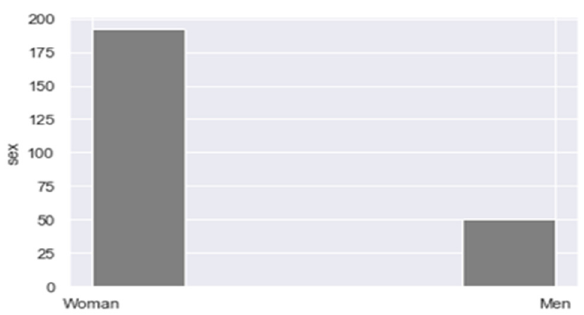
Figure A1. Profile of respondents by gender. Source: own research.